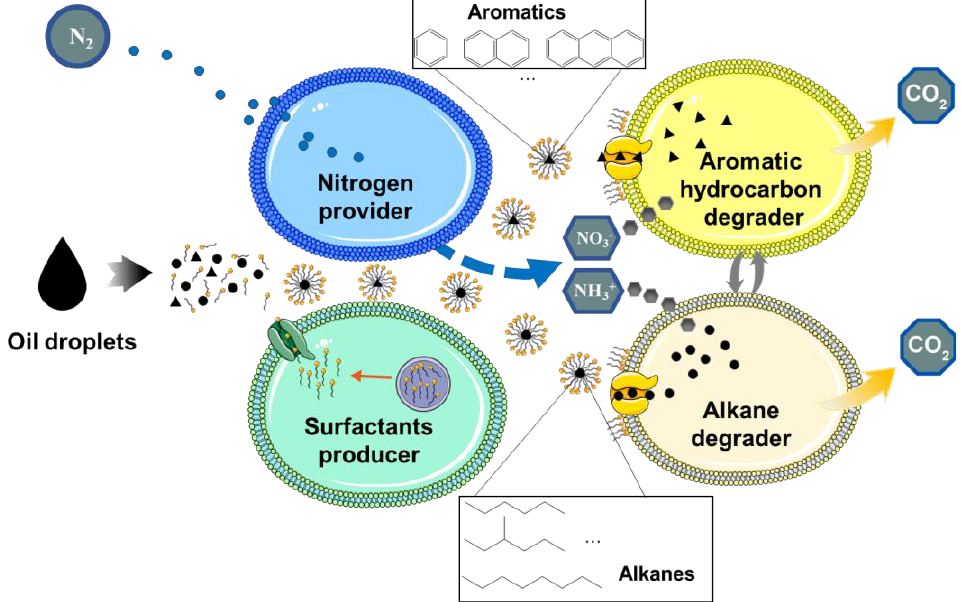
Figure 2. Microbial community for petroleum hydrocarbon contaminant biodegradation.